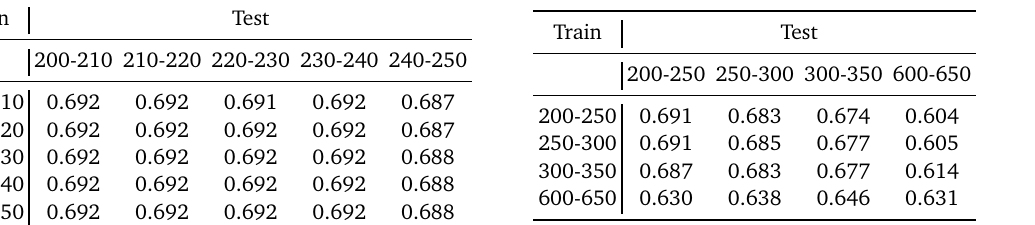
Figure 7: Left: representative Feynman diagrams for the mono-jet signal and Z + jets background. Right: fraction of events with a leading jet above p min initiated leading jets in H + jets events (red) and quark-initiated jets in Z + jets events (blue) as a function of p . The bottom panel shows the ratio of the two gluon T , j fractions.